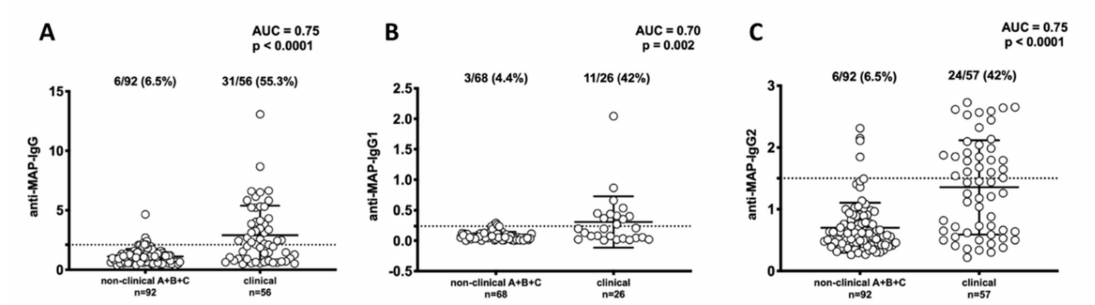
Figure 2. Anti- Mycobacterium avium subsp. paratuberculosis (MAP) titers in serum from dogs raised in Japan. Non-clinical samples were obtained from three institutes and clinical samples were obtained from veterinary hospitals in Japan. ( A ) titers anti-MAP-IgG, ( B ) titers anti-MAP-IgG 1 , ( C ) titers anti-MAP-IgG 2 . Dot plot showing the distribution of total IgG detected by ELISA. The horizontal bars represent the median plus interquartile range, while the percent fraction of antibody positive sera, area under ROC curve (AUC) and p -values are indicated on top of distribution. The dotted line lines designate the cuto ff for positivity used in each assay, as calculated by ROC